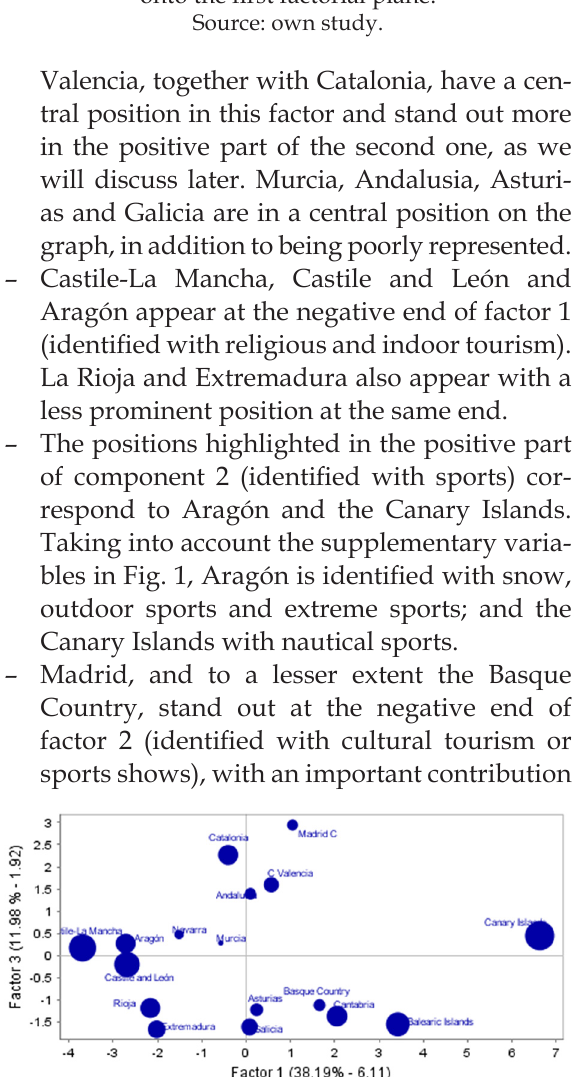
Fig. 2. Projection of the autonomous communities onto the first factorial plane.